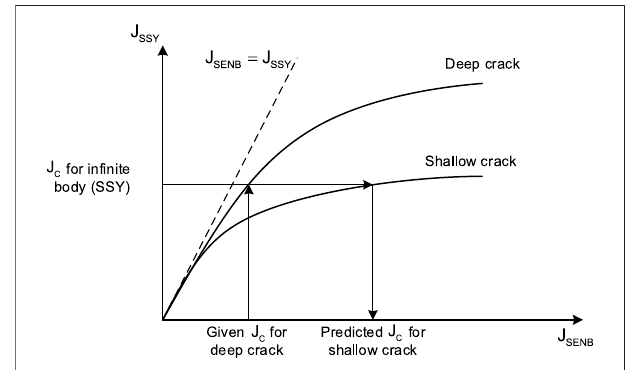
FIGURE 1 | Schematic of the relationship between the J-integral values inSENBspecimensfordeepandshallowcrackswiththoseofSSYconditions which generate equivalent opening mode stresses ahead of the crack